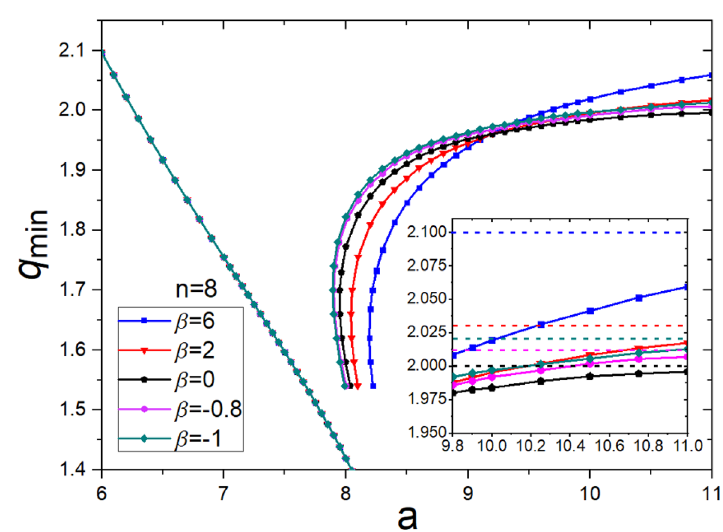
Figure 7 . Phase diagram of the minimal charge q min as a function of the amplitude a , with fixed n = 8 and for several values of β = 6 , 2 , − 0 . 8 , − 1 , and the black solid line represents β = 0 for